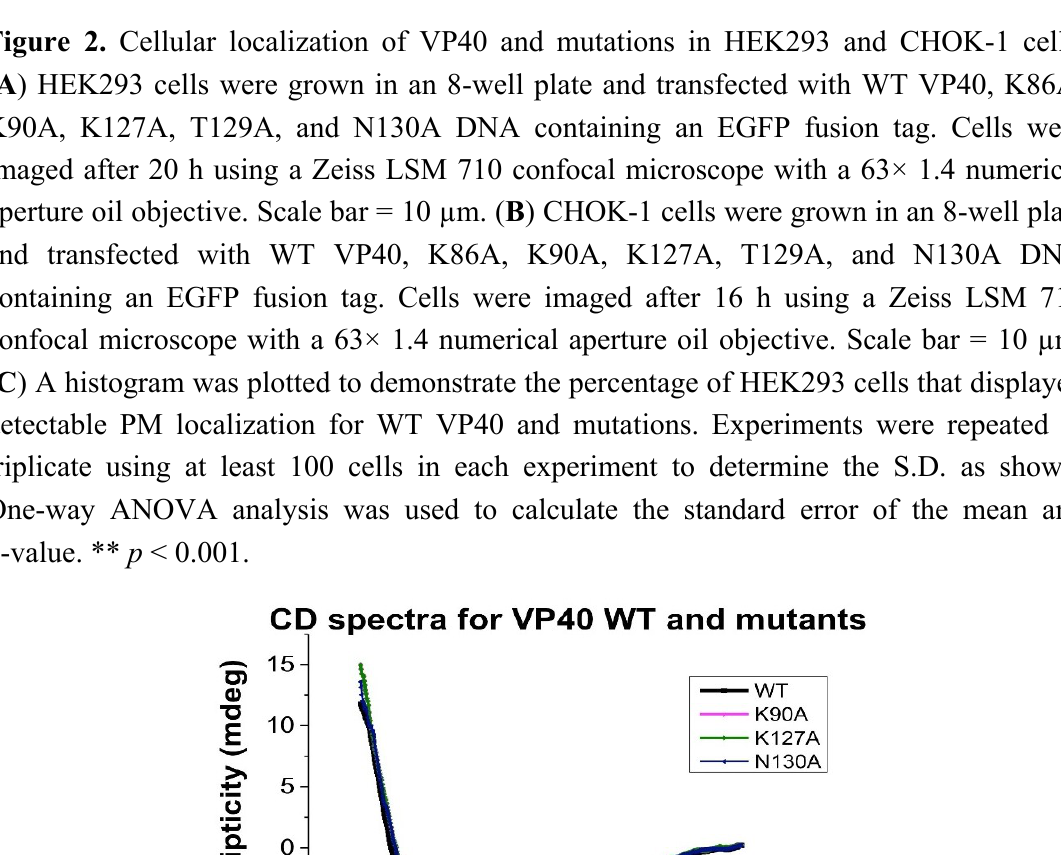
Figure 2. Cellular localization of VP40 and mutations in HEK293 and CHOK-1 cells. ( A ) HEK293 cells were grown in an 8-well plate and transfected with WT VP40, K86A,